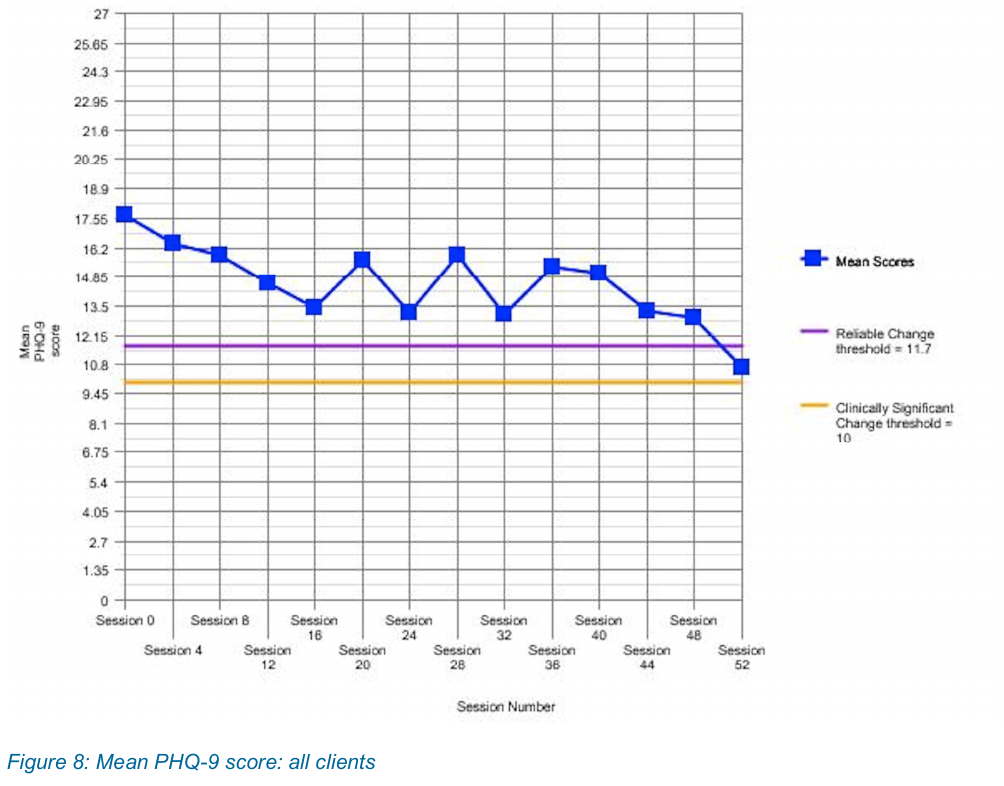
Figure 8: Mean PHQ-9 score: all clients